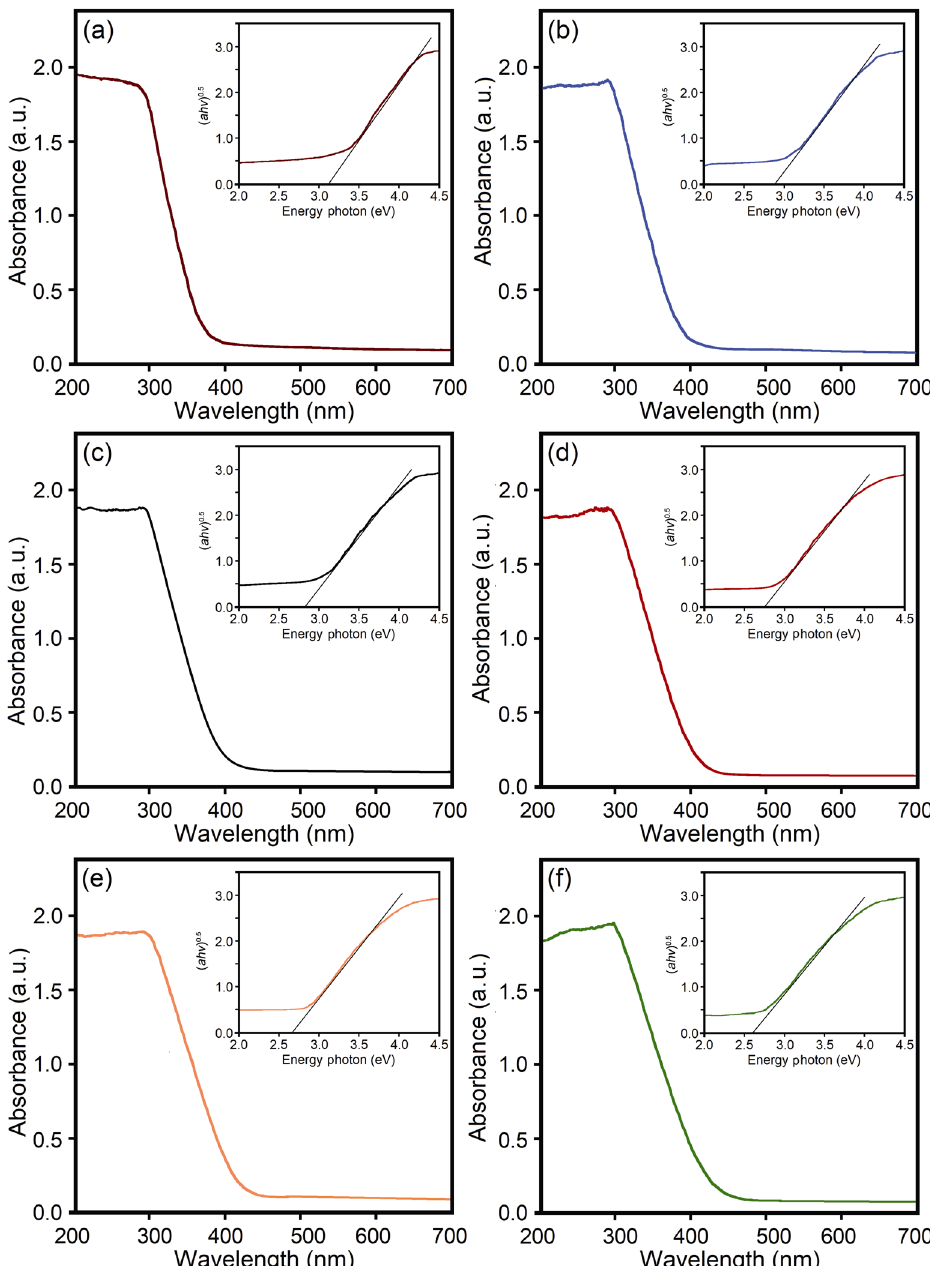
Fig. 7 UV–vis absorbance spectra of (a) the undoped TiO 2 nanorod and N–Fe codoped TiO 2 nanorods annealed at (b) 400 ℃ , (c) 500 ℃ , (d) 600 ℃ , (e) 700 ℃ , and (f) 800 ℃ . The insets present corresponding plots of ( αhν ) 0.5 versus photon energy ( hν ) for